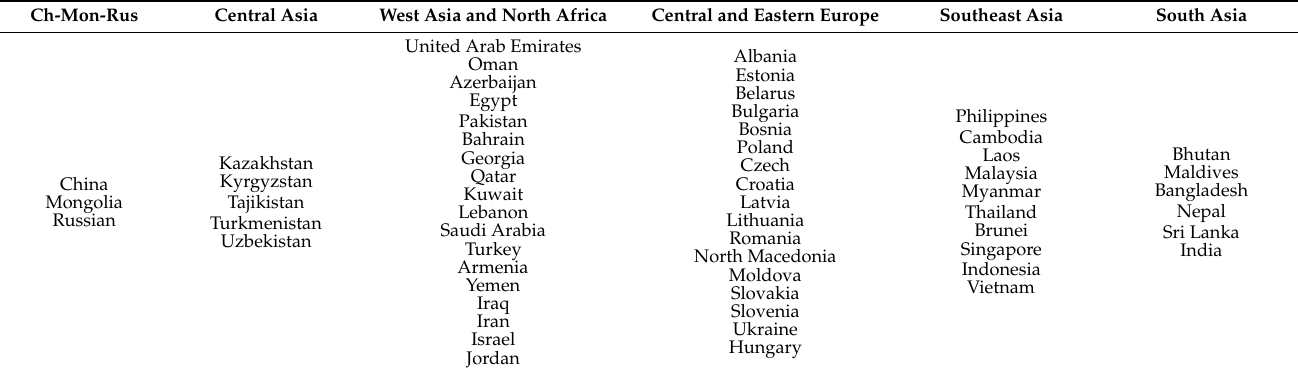
Table 1. 59 Belt and Road Countries.